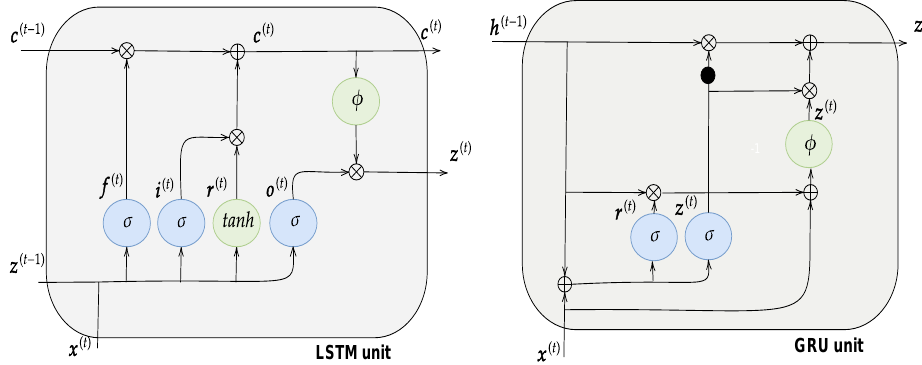
Figure 1. A pictorial representation of the LSTM unit ( left ) and GRU unit ( right